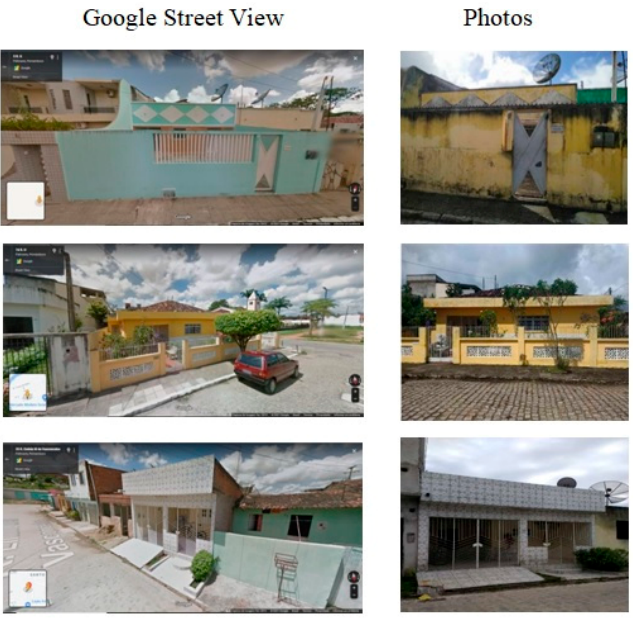
Figure 6. Google Street View (2012) versus Photos